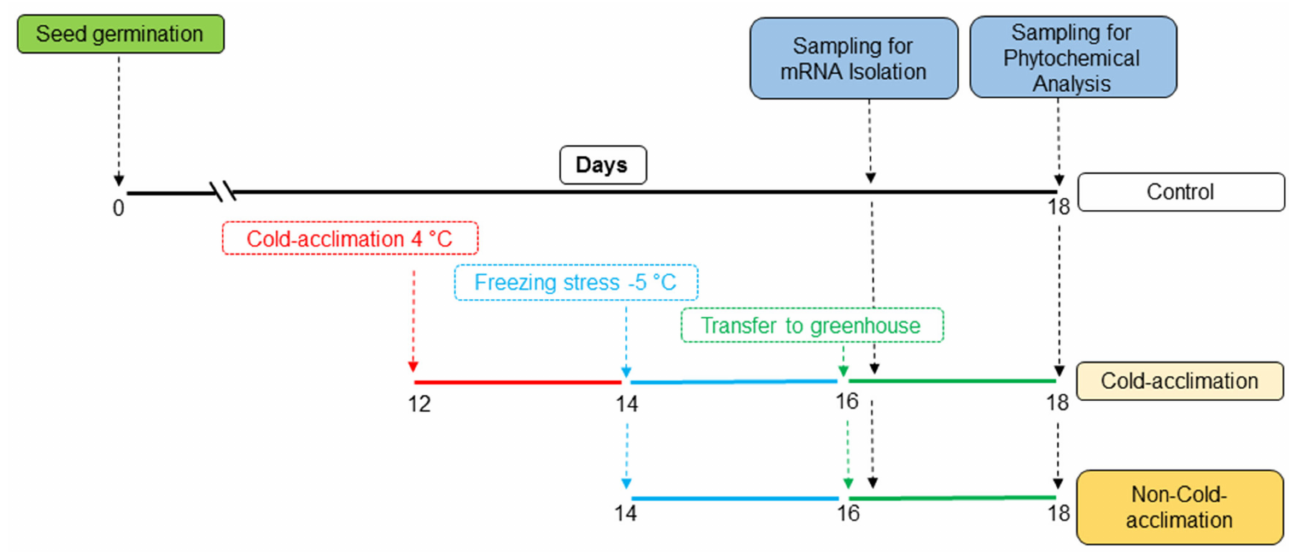
Figure 4. The schematic diagram illustrating the experiment and treatment